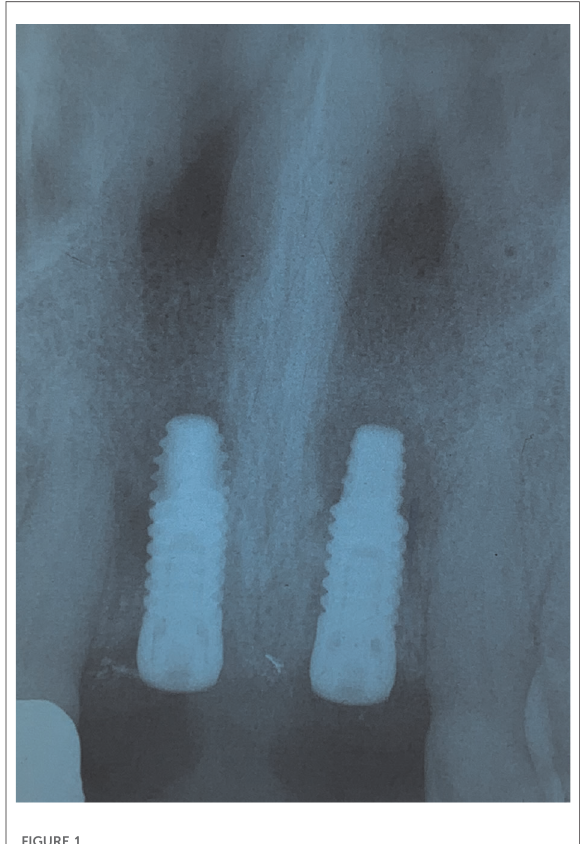
FIGURE 2 Periapical radiograph showing a radiolucency at apex of implant